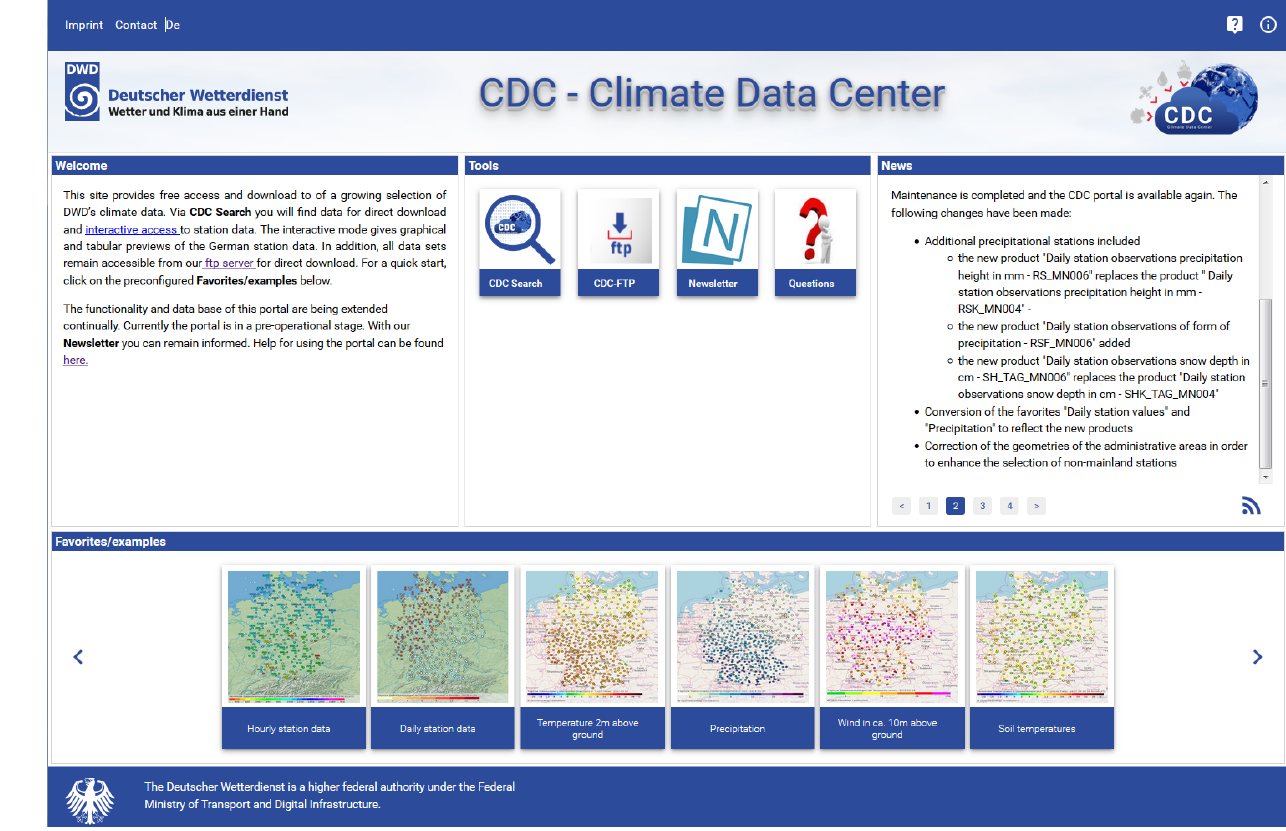
Figure 1. Homepage of the interactive Climate Data Center portal (Source: Deutscher